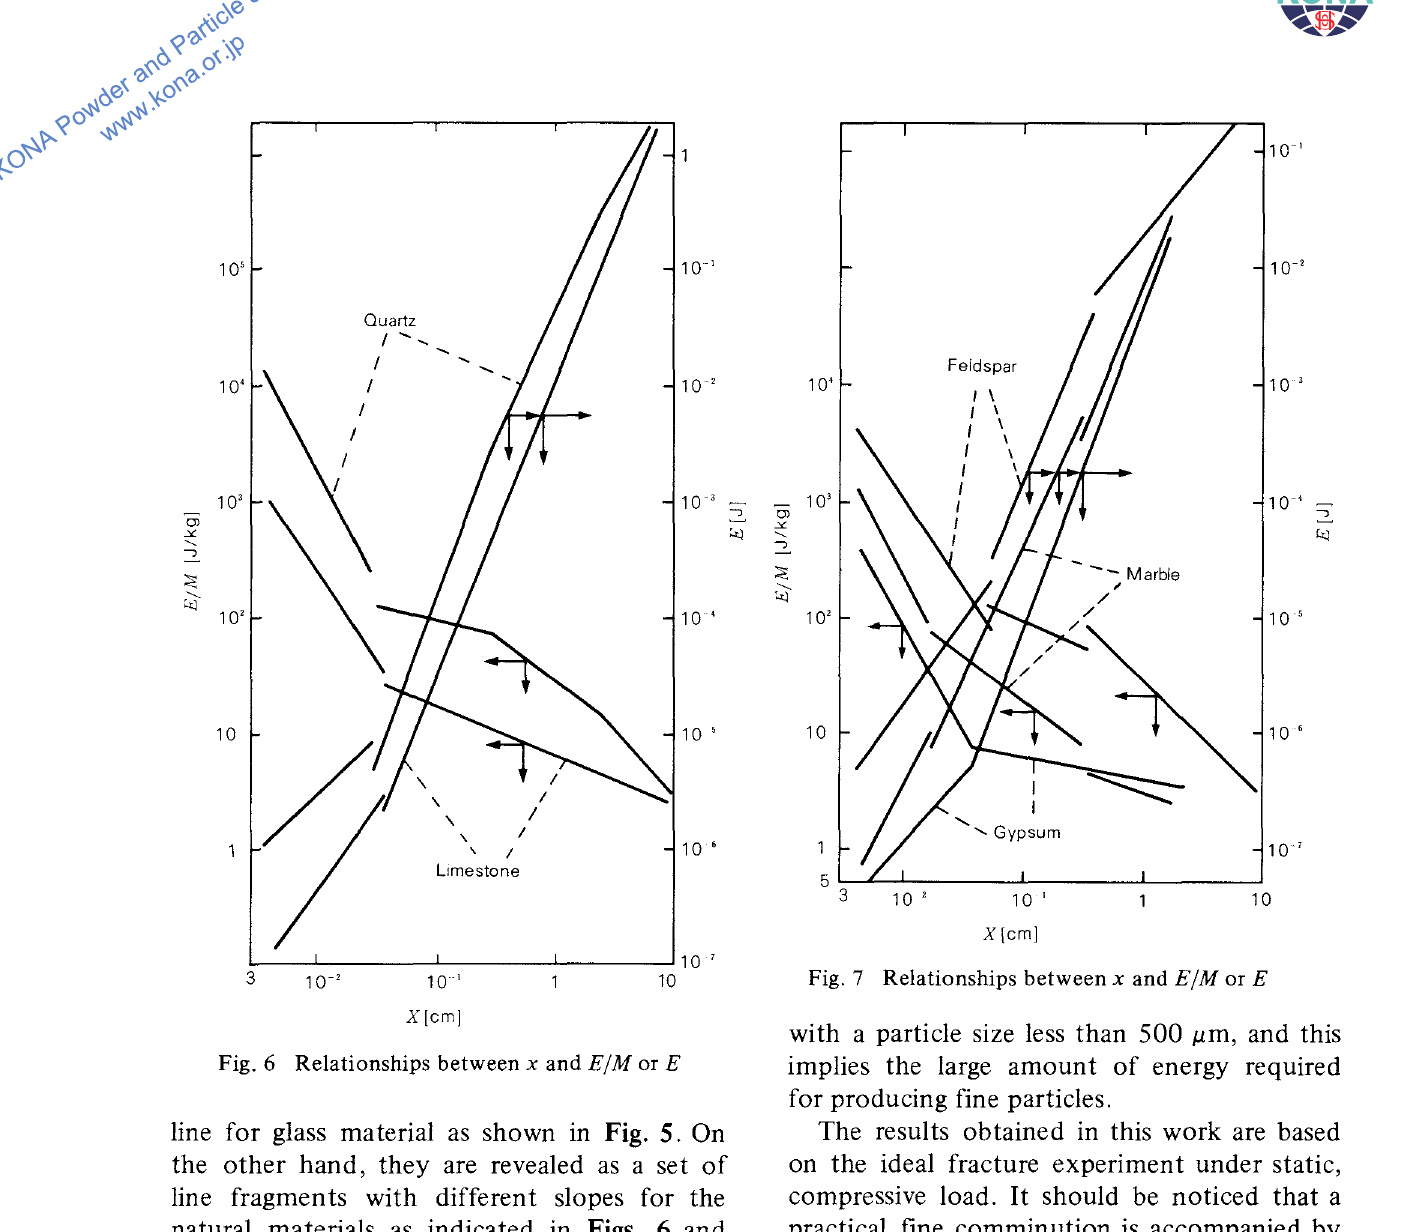
Fig. 7 Relationships between x and E/M